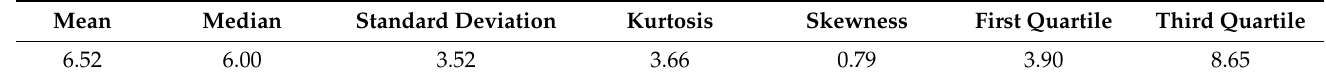
Table 1. Main wind speed statistics (m/s).